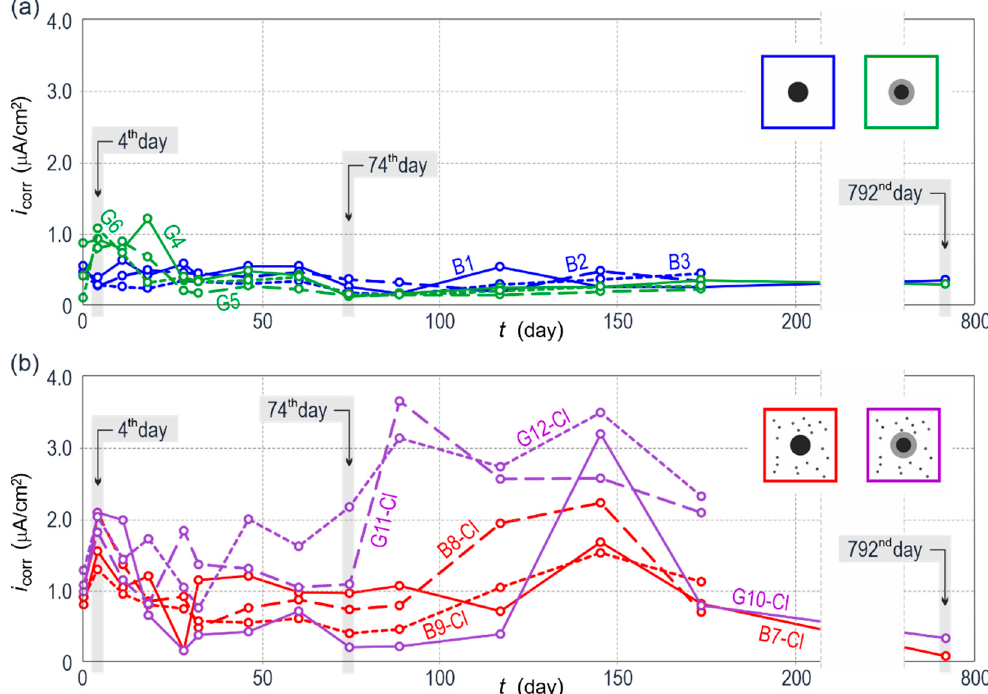
Figure 21. Changes in the function of time for corrosion current densities i corr of galvanized and black steel reinforcement ( a ) in concrete without chlorides, ( b ) in concrete with chlorides; selected measuring series presented as diagrams and analyzed in details as part of EIS and LPR measurements are marked with grey color.